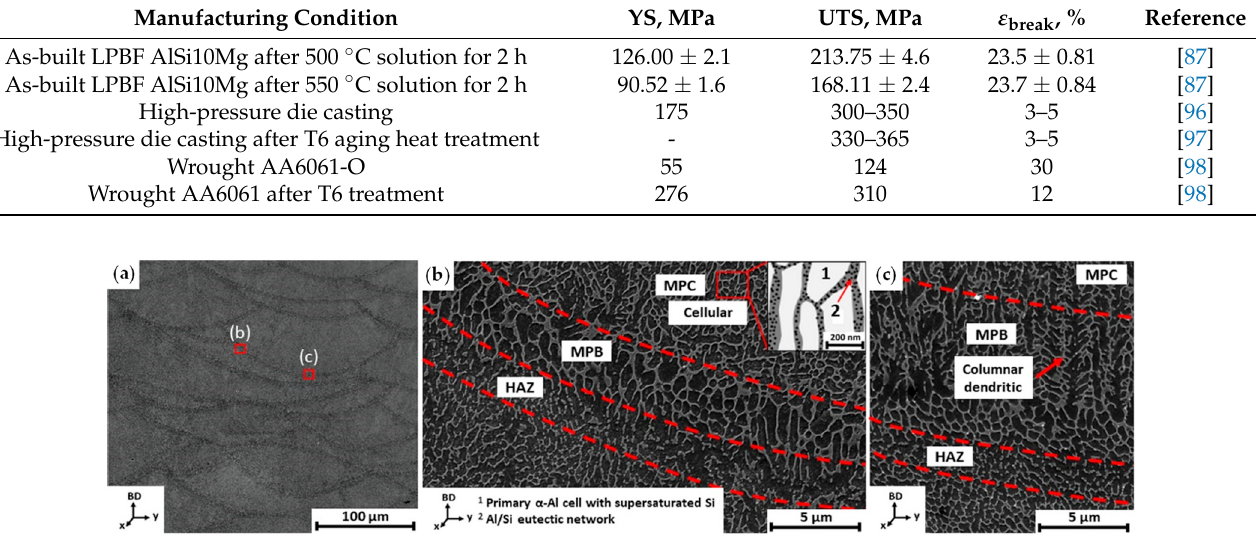
Figure 1. SEM images of cast Al alloy—AlSi10Mg printed by the 3D SYSTEMS DMP printer: ( a ) As-printed overall microstructure shows a high density. Microstructural details reveal ( b ) cellular grains at the melt pool center (MPC) and ( c ) columnar dendritic grains at the melt pool boundary (MPB) and heat-affected zone (HAZ). Reproduced with permission from Springer Nature [95]. Table 4. Mechanical properties of the LPBF ‐ built and cast AlSi10Mg after solution and T6 aging heat treatment compared with wrought counterparts and AA ‐ 6061 alloys.